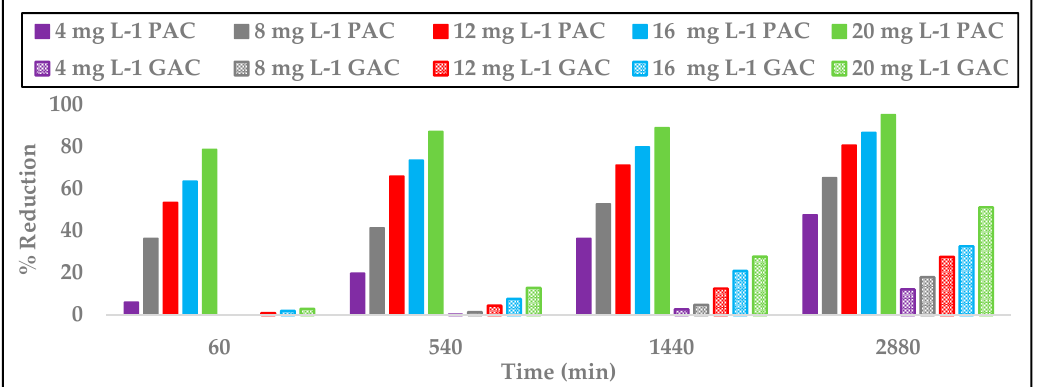
Figure 6. Simazine reduction using PAC and GAC with different contact times. Experimental conditions: [Simazine 0 ] = 0.7 mg L − 1 ; [PAC] and [GAC] = 4–20 mg L − 1 ; pH 0 6.7; T = 25 °C.